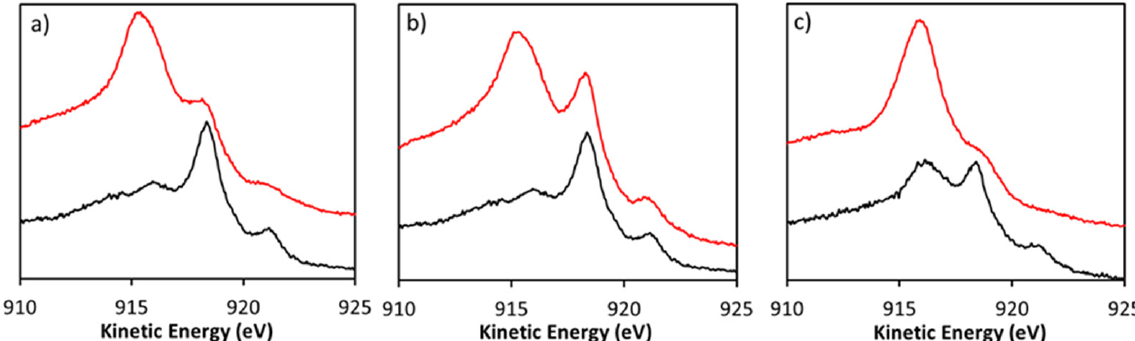
Figure 11. Cu LMM Auger signal of ( a ) CF-18H ( b ) CF-18H-100U and ( c ) CF-18H-DCU, before electrolysis (black signal) and post 35 min electrolysis (red signal).